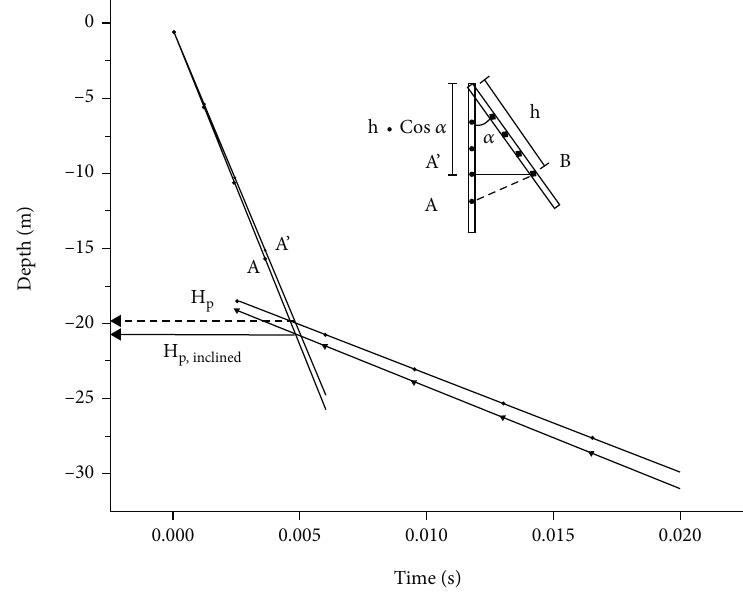
Figure 5: The schematic diagram of fi eld operation errors due to tilted side holes.